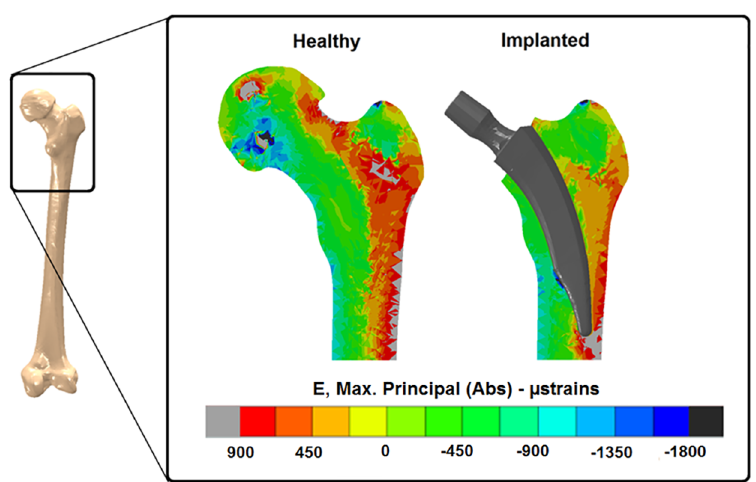
Fig 7. Maximum absolute principal strains at the mid-coronal cross section of the proximal part of the femur for intact and implanted model with the Nanos ® short stem.